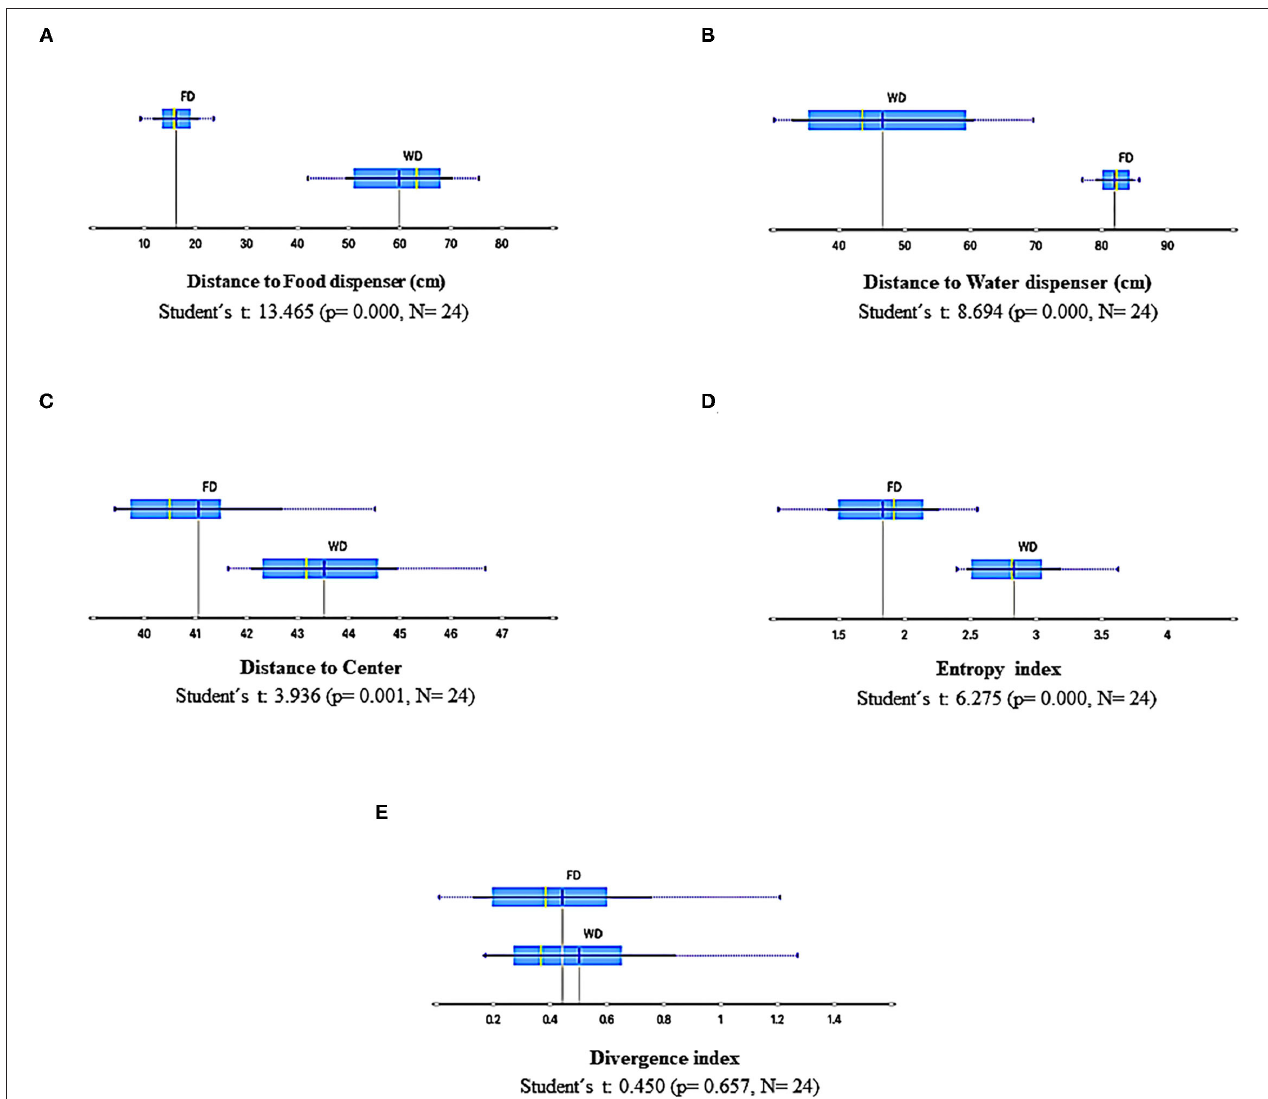
FIGURE 9 | Summary results of spatial-behavior measures for all sessions and subjects under FD and WD schedules. (A) , Distance to food dispenser; (B) , Distance to water dispenser; (C) , Distance to center; (D) , Entropy; (E) , Divergence. Each box depicts the mean (dark blue vertical line), the median (yellow vertical line), the standard deviation (thin blue line), and the values between the first and the third quartile (blue highlighted